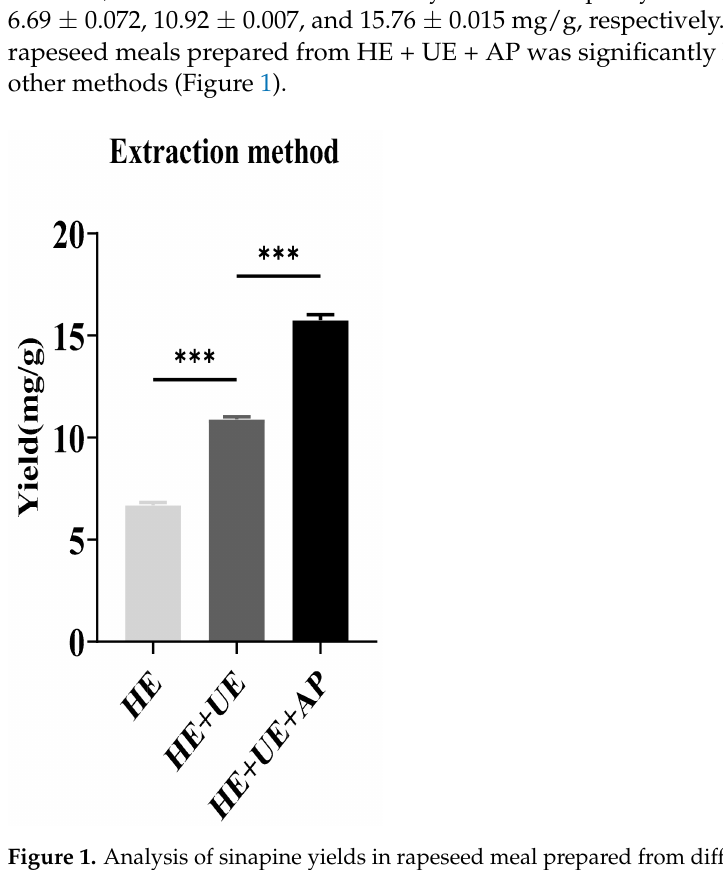
Figure 1. Analysis of sinapine yields in rapeseed meal prepared from different extraction techniques. (HE, hot-ethanol extraction; HE + UE, hot-ethanol extraction and ultrasonic extraction; HE + UE + AP, hot-ethanol extraction with ultrasonic extraction combined with anti-solvent precipitation). Note: *** p <